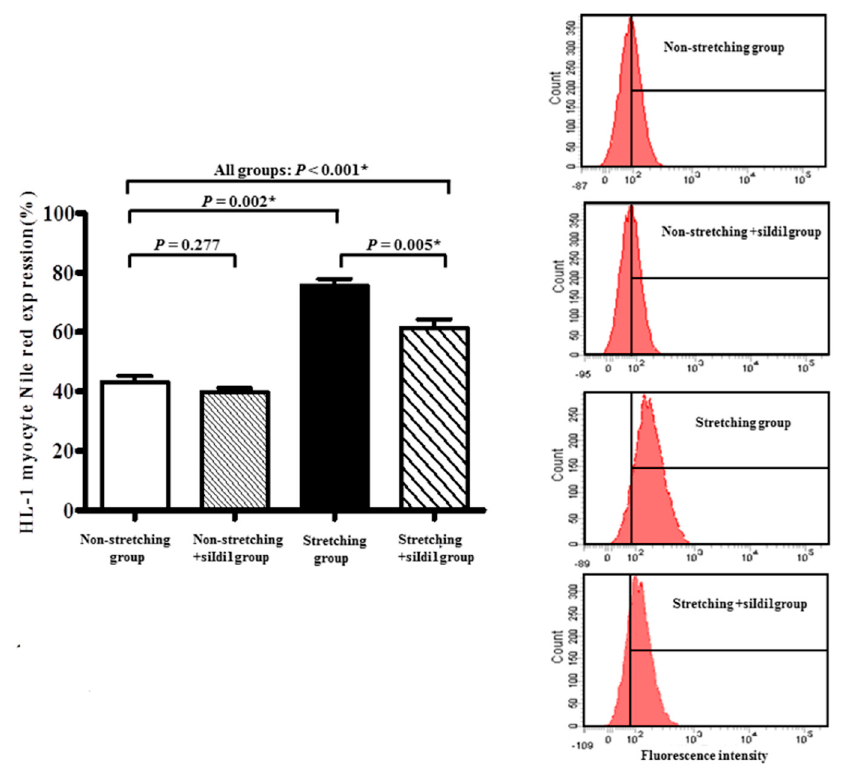
Figure 6. The fraction of HL-1 atrial myocytes expressing Nile red was determined by flow cytometry. Left panel: Comparison of fraction of HL-1 atrial myocytes expressing Nile red in non-stretched HL-1 atrial myocytes, non-stretched HL-1 atrial myocytes with genetic silencing of the Idi1 mRNA, stretched HL-1 atrial myocytes, and stretched HL-1 atrial myocytes with genetic silencing of the Idi1 mRNA. Right panel: Fluorescence intensity measurements for Nile red expression in non-stretched HL-1 atrial myocytes, non-stretched HL-1 atrial myocytes with genetic silencing of the Idi1 mRNA, stretched HL-1 atrial myocytes, and stretched HL-1 atrial myocytes with genetic silencing of Idi1 mRNA. * p < 0.05.